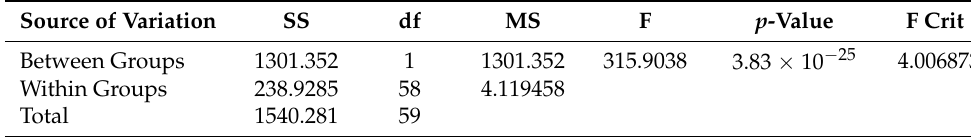
Table 3. ANOVA single factor result between RFA and AI for left foot.